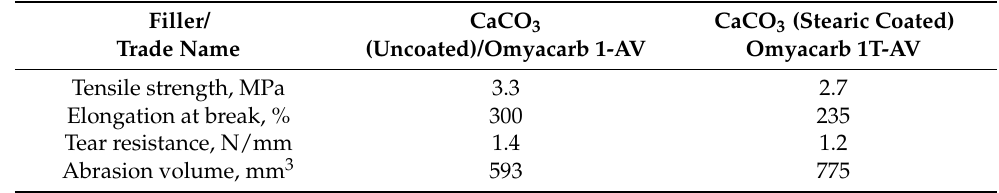
Table 5. Comparison of mechanical properties in the different CaCO 3 filled EPDM/CaCO 3 composites.